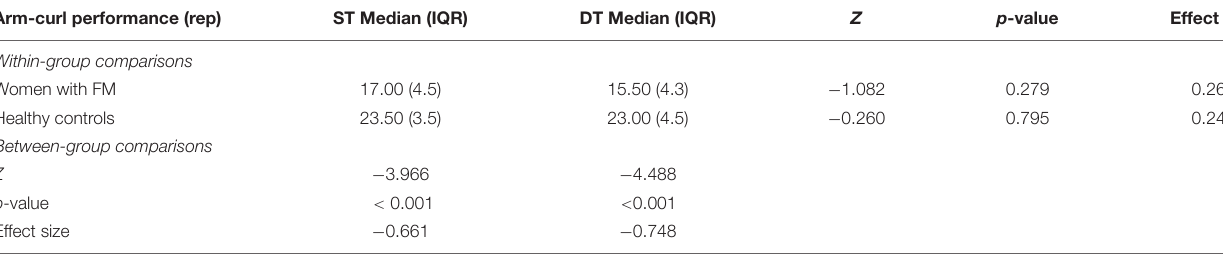
TABLE 2 | Within- and between-group comparisons in the arm-curl test during ST and DT in women with FM and healthy controls. Arm-curl performance (rep) ST Median (IQR) DT Median (IQR) Z p -value Effect size